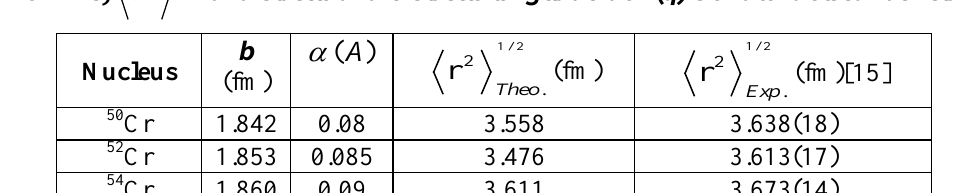
2/1 .2 r (fm)[15] Exp